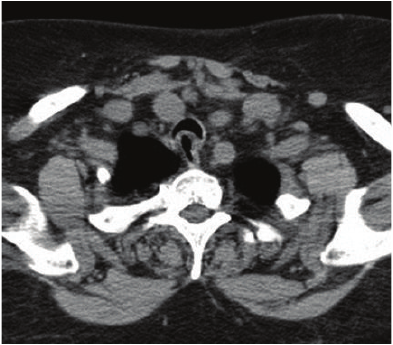
Figure 3: Healing with evidence of granulation tissue on POD 8.